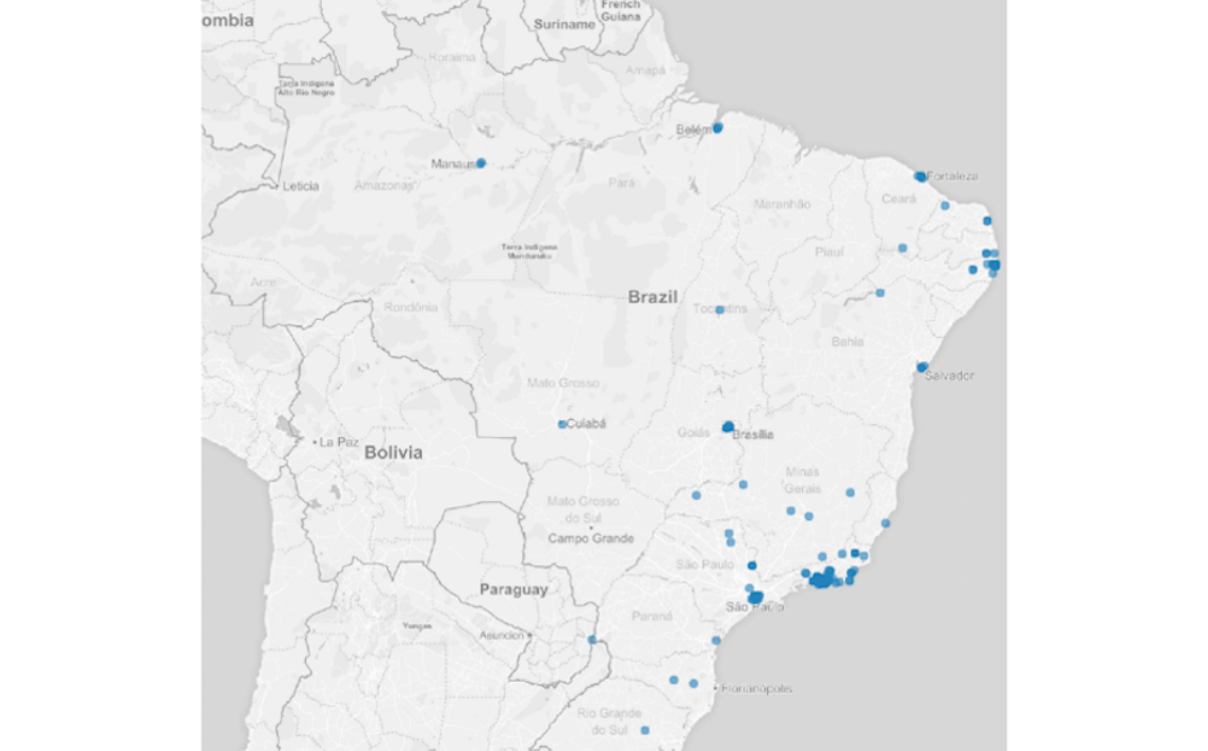
Figure 5. Spatial distribution of reports from users with diarrheal syndrome during the 2016 Olympic